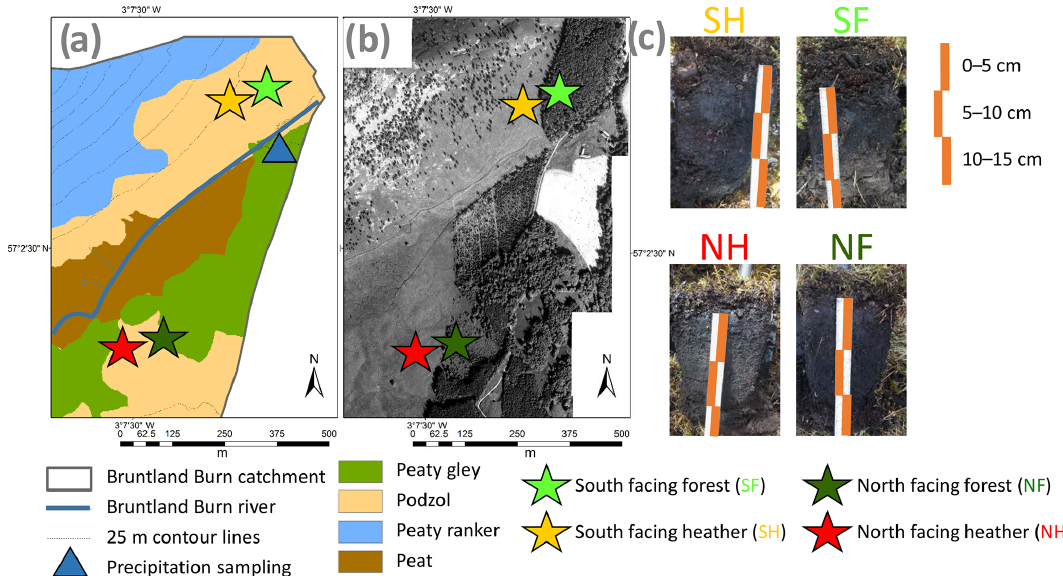
Figure 1. Location of the four sampling sites within the Bruntland Burn catchment on (a) a soil map and (b) an aerial photo. The precipitation sampling location is indicated by a blue triangle in (a) . (c) The four photos on the right show exemplary soil profiles for the four study sites. Table 1. Vegetation and soil profile characteristics of the four study sites: percentage of coarse gravel (>20mm diameter) and fine gravel (20–2mm diameter) of the soil sample, percentage of sand (S, 2–0.6mm), silt (Si, 0.06–0.002mm), and clay (C, <0.002mm) of the fine-soil matrix. Percentage of organic matter content in the soil as loss on ignition (LOI), correlation characteristics for LOI with depth and with gravimetric water content (GWC), and fine root density as percentage of total root mass. Note that for SH, NF, and SF not enough fine soil was left for soil texture analysis after ignition of organic material at 550 ◦ C and that for NF and SF, no root density could be measured due to root thickness and stone content. ± indicate standard deviations out of five replicates for LOI values and range of two and three replicates for root density,